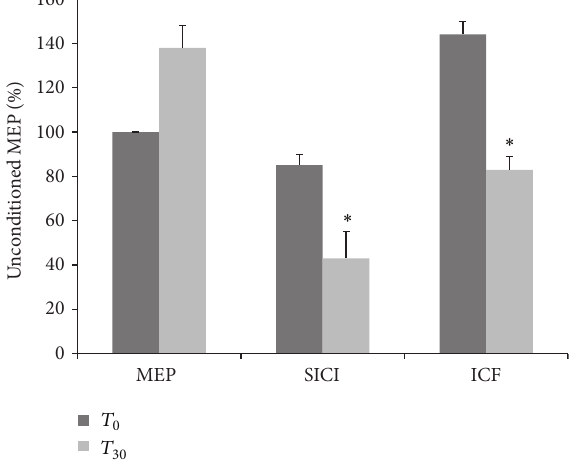
Figure 1: MEP, SICI, ICF, and CSP modifications after one month of Sativex intake.